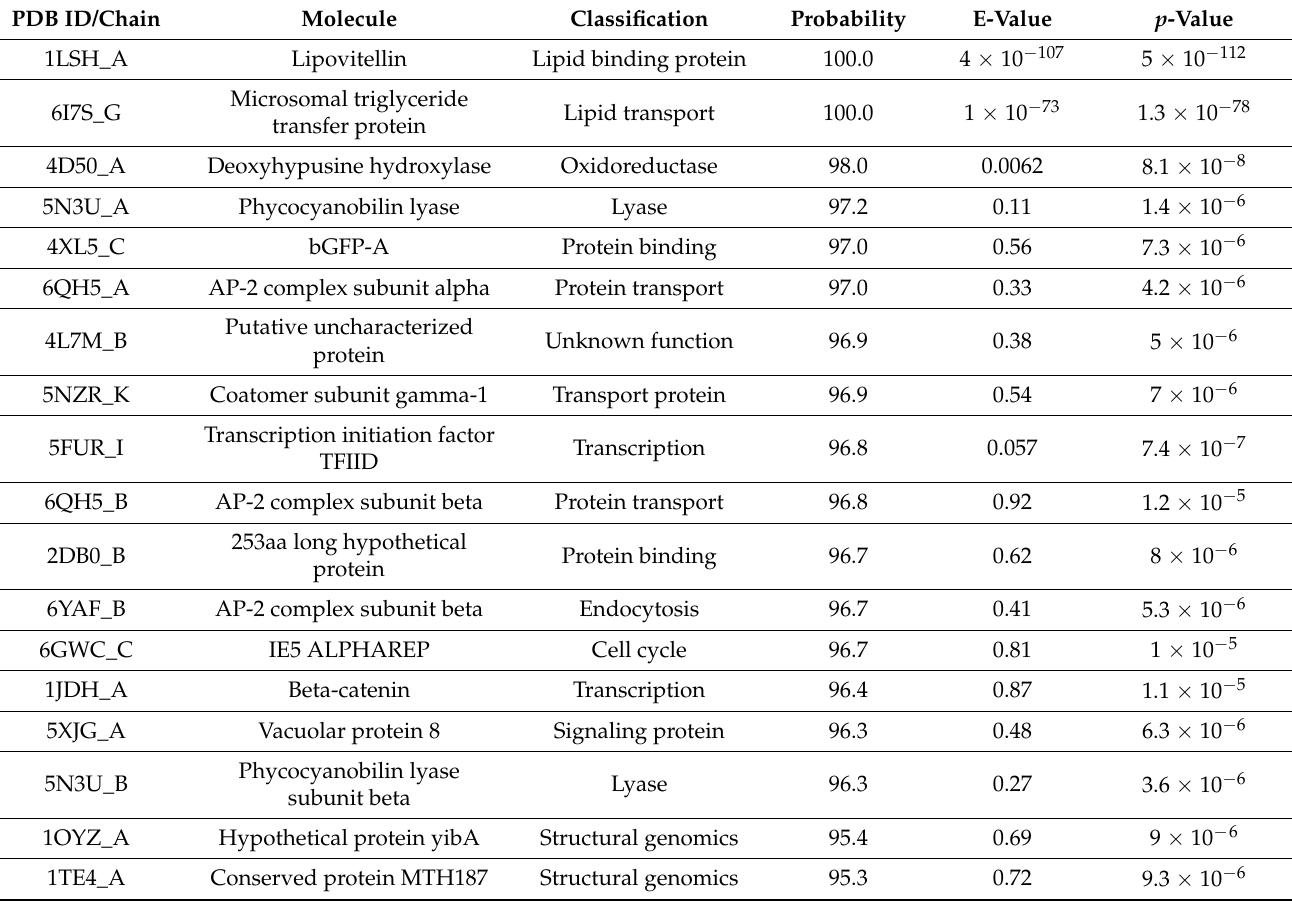
Table 1. Selected homologous templates for Subunit